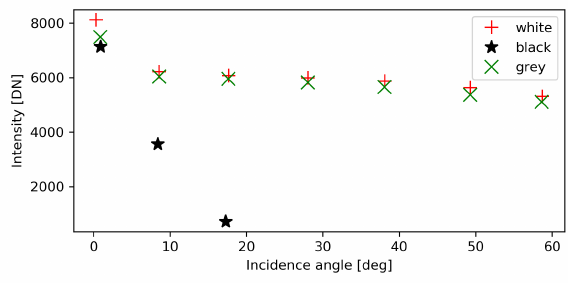
Figure 7. VZ-2000i recorded intensity vs. incidence angle for a constant range of 60m .